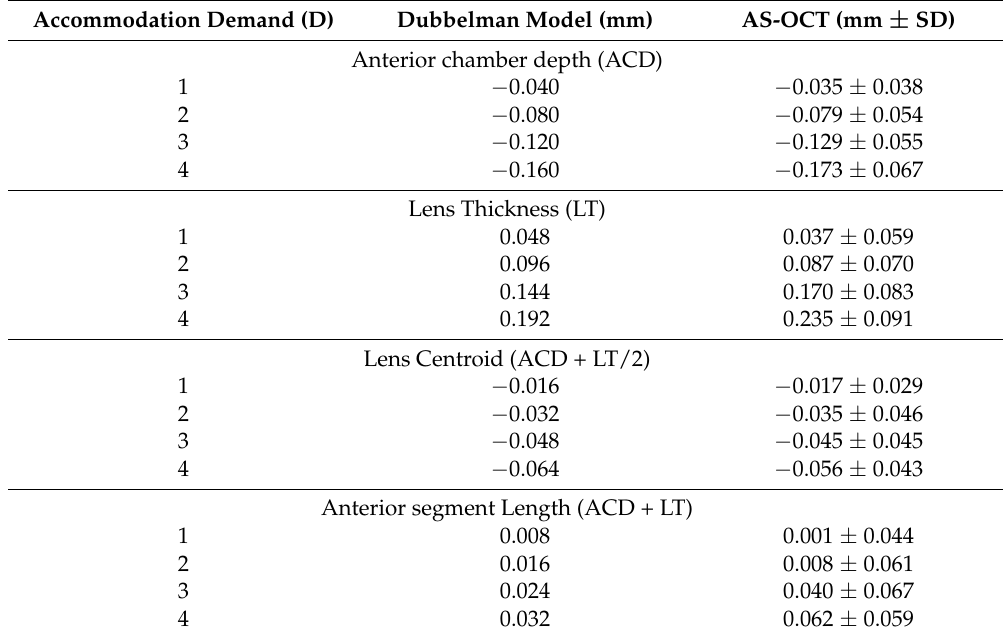
Table 3. Anterior eye relative axial distance changes with accommodation demand measured with the AS-OCT, compared to the Dubbelman model eye data [65]. The average age of the cohort has been matched to that of the model (19.4 years old; n =